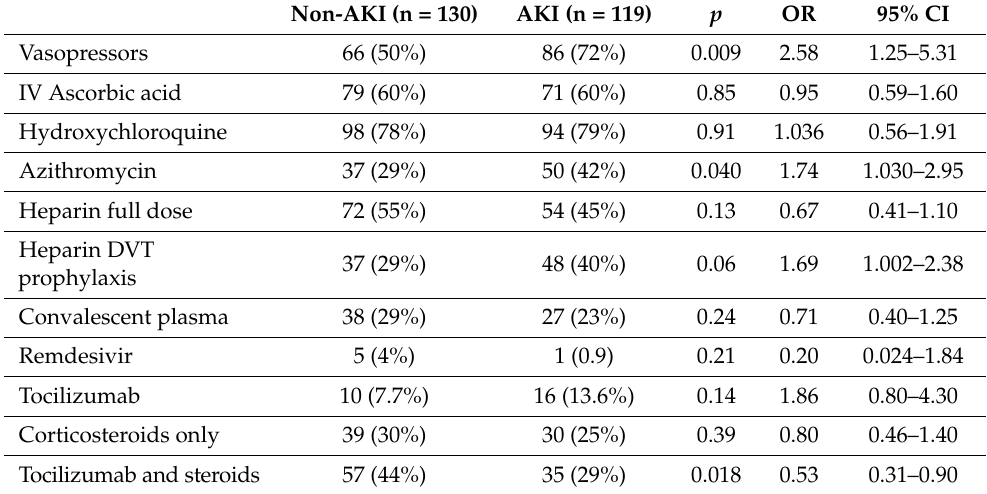
Table 2. Pharmacological interventions in COVID-19 ICU patients with and without AKI.